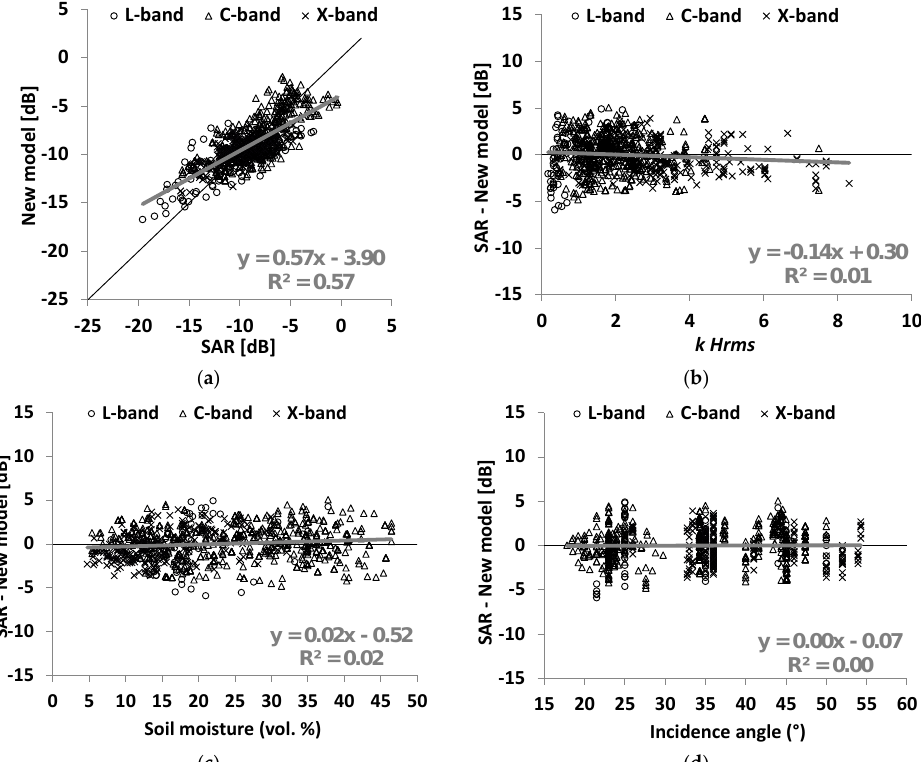
Figure 4. ( a ) Comparison between σ ◦ in the new model and σ ◦ measured (for all SAR bands) for VV polarization; ( b ) the difference between SAR and the new model as a function of surface roughness ( kHrms ); ( c ) the difference between SAR and the new model as a function of soil moisture ( mv ); and ( d ) the difference between SAR and the new model as a function of incidence angle. The best regression model is plotted in gray. The comparison between the new model simulations in HV polarization Equation (7) and the real data (SAR data) shows an RMSE of 2.1 dB (Table 3) (1.6 dB in the L-band, 2.2 dB in the C-band, and 1.9 dB in the X-band). The bias ( °SAR—model) is −1.3 dB in the L-band, 0.2 dB in the C-band, and −1.3 dB in the X-band. Figure 5 shows also that the new model correctly simulates the radar backscatter coefficient in HV for all ranges of soil moisture, surface roughness, and radar incidence angle.